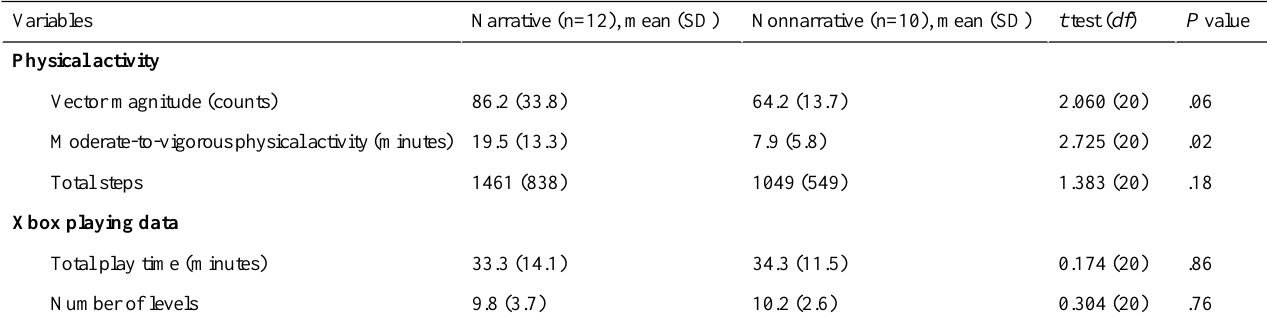
Table 2. Physical activity and active video game data.